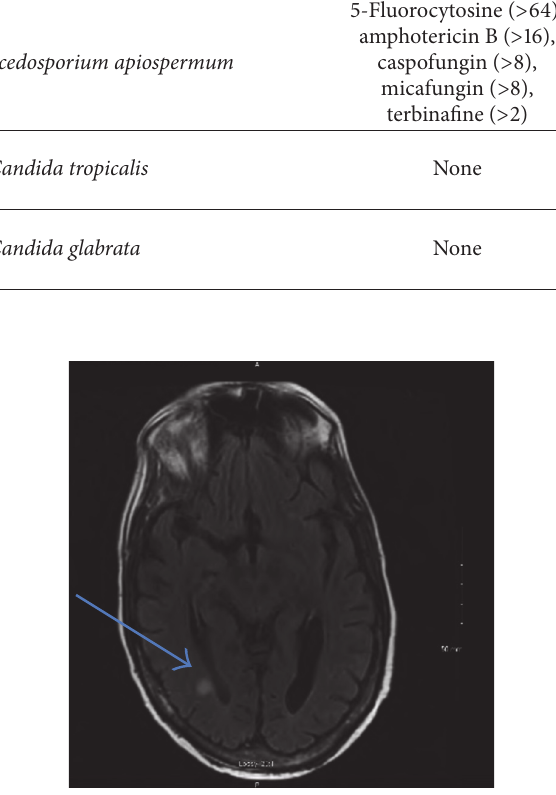
Figure 2: MRI of the brain. Multiple ring-enhancing lesions with associated diffusion restriction and T2/FLAIR hyperintensity are present throughout the supratentorial white